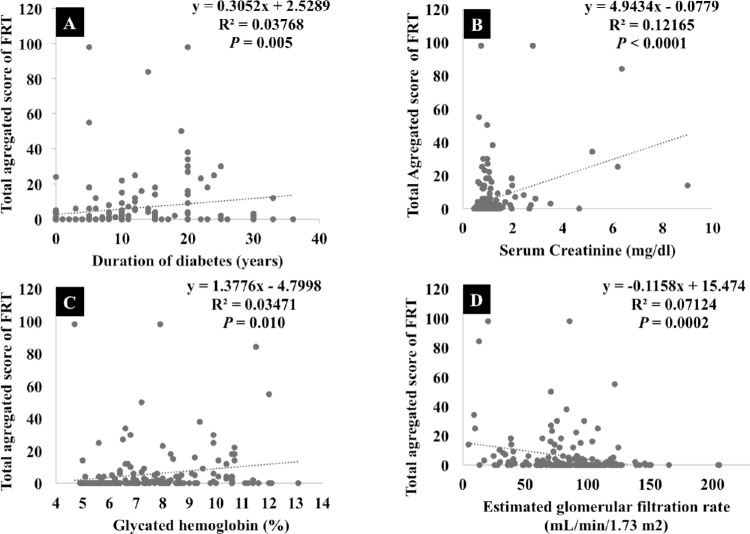
Scatterplot with linear regression of TAS of focal retinal thinning plotted against (A) duration of diabetes, (B) glycosylated hemoglobin, (C) eGFR, and (D) serum creatinine.